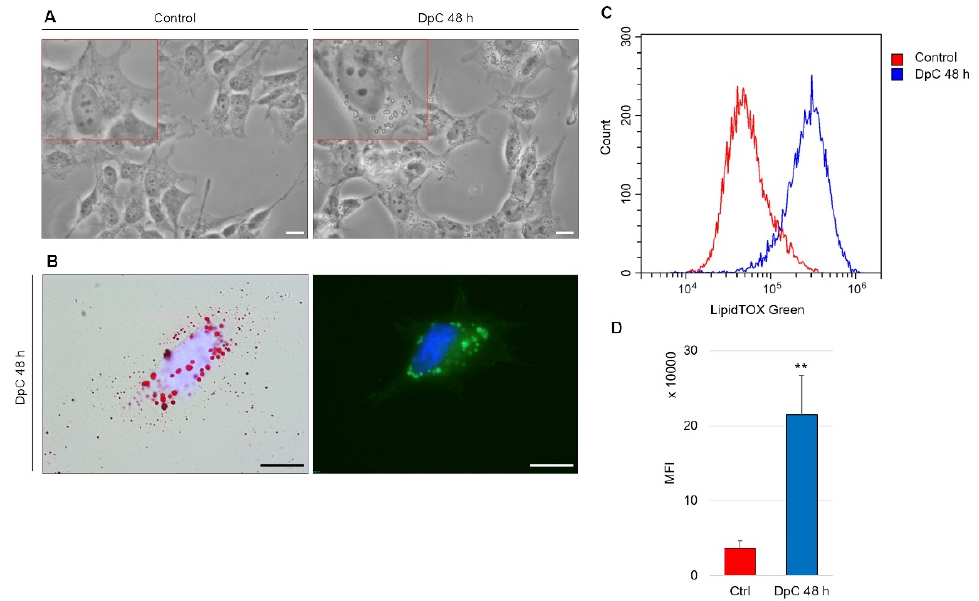
Figure 8. Lipid accumulation in SH-SY5Y neuroblastoma cells in response to DpC treatment. ( A ) Light-microscopy micrograms revealing spherical bodies in the cytoplasm of SH-SY5Y cells. ( B ) Neutral lipid staining of DpC-treated cells by Oil Red O (red, left) and LipidTOX™ Green (green, right). Nuclei counterstained with Hoechst 33342 (blue). Scale bar: 20 μ m. ( C , D ) Increase in the median fluorescence intensity (MFI) of LipidTOX™ Green emission after DpC treatment. MFI ± SD comprised of three independent experiments. ** p < 0.01.